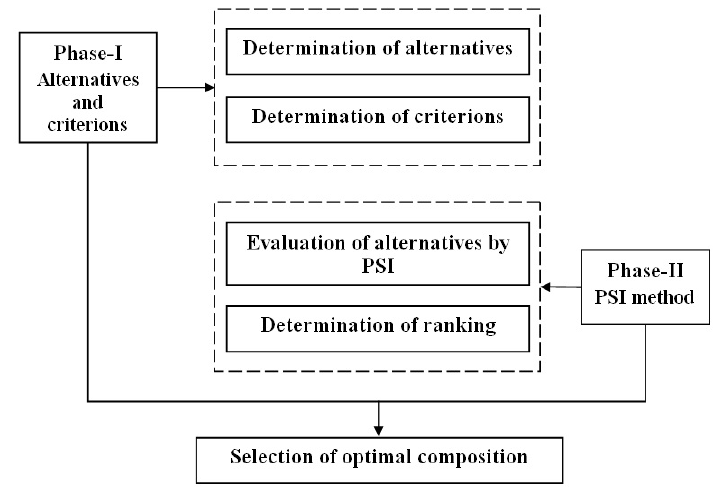
Figure 2. Optimization methodology for selection of the optimal composition.